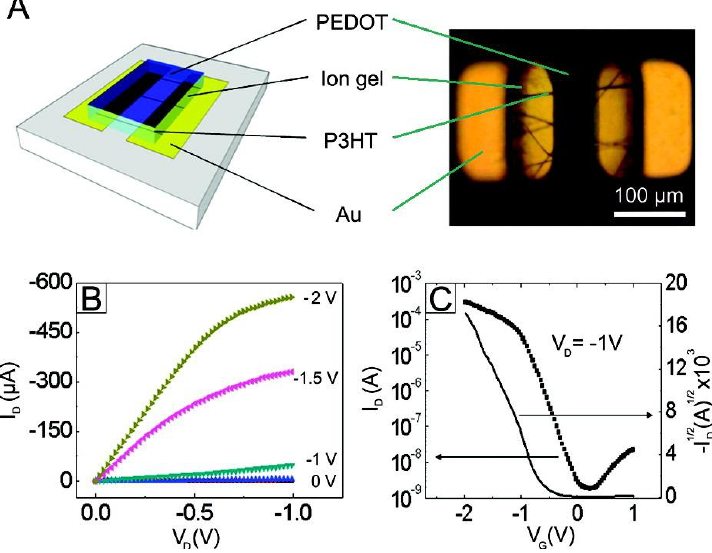
Figure 8. Example of device structure and optical microscopy of ( a ) an ion-gel fiber FET. In ( b ) and ( c ) the output and the transfer characteristic curves are reported, respectively Reprinted with permission from [148]. Copyright (2012) by